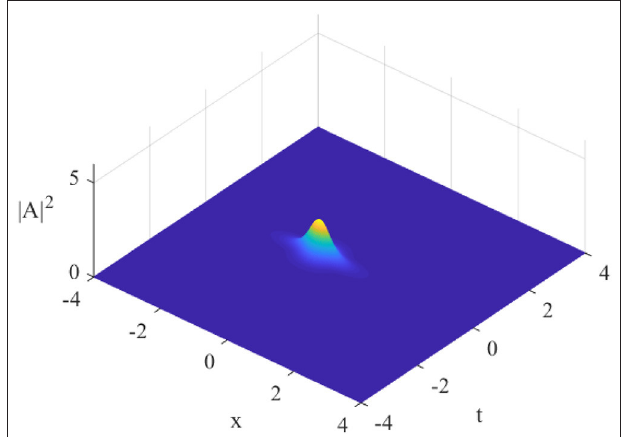
FIGURE 1 | Wave profile of the intensity of the wave envelope in physical space, | A | 2 (Equation 4 through Equation 7), vs. spatial coordinate x and time t , b = 1.5. The rogue wave has one single maximum. The profile for | B | 2 is similar.